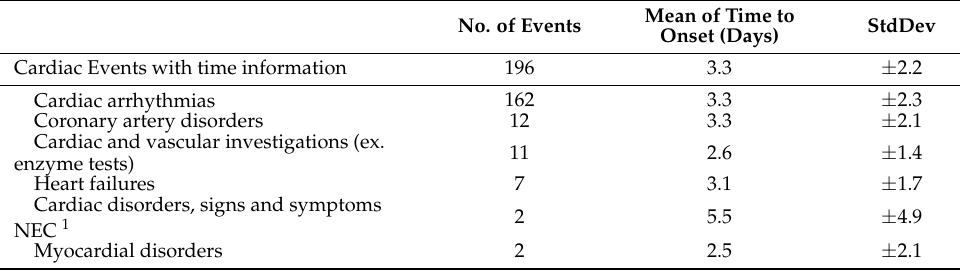
Table 5. Description of time-to-onset for cardiac events.